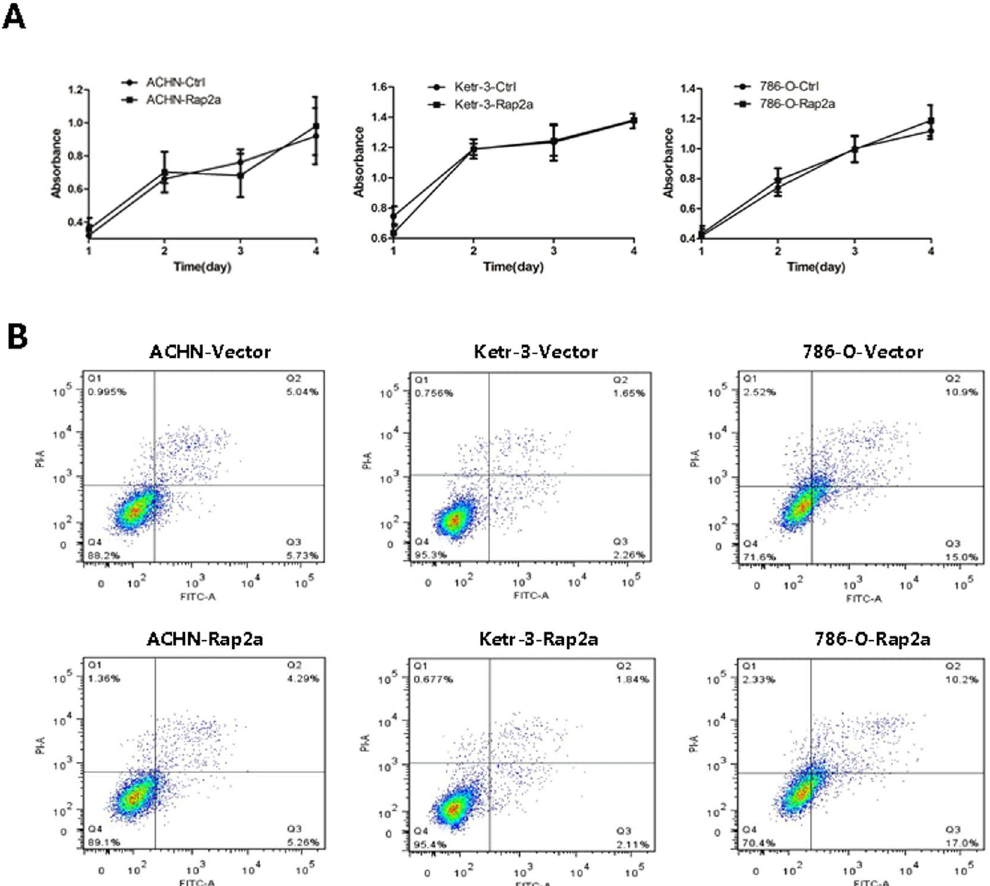
Figure 4. Effects of Rap2a overexpression on RCC cells proliferation. ( A ) CCK-8 assay was performed in ACHN, Ketr-3 and 786-O cells after transfection of pcDNA3.1-Rap2a/pcDNA3.1 empty vector expression plasmids for 24, 48, 72 and 96 h. ( B ) The apoptotic cells were determined by annexin V-FITC/PI staining using flow cytometry. Rap2a has no effect on the proliferation and apoptosis of RCC cells. Data are presented as mean ± SD (n = 3).